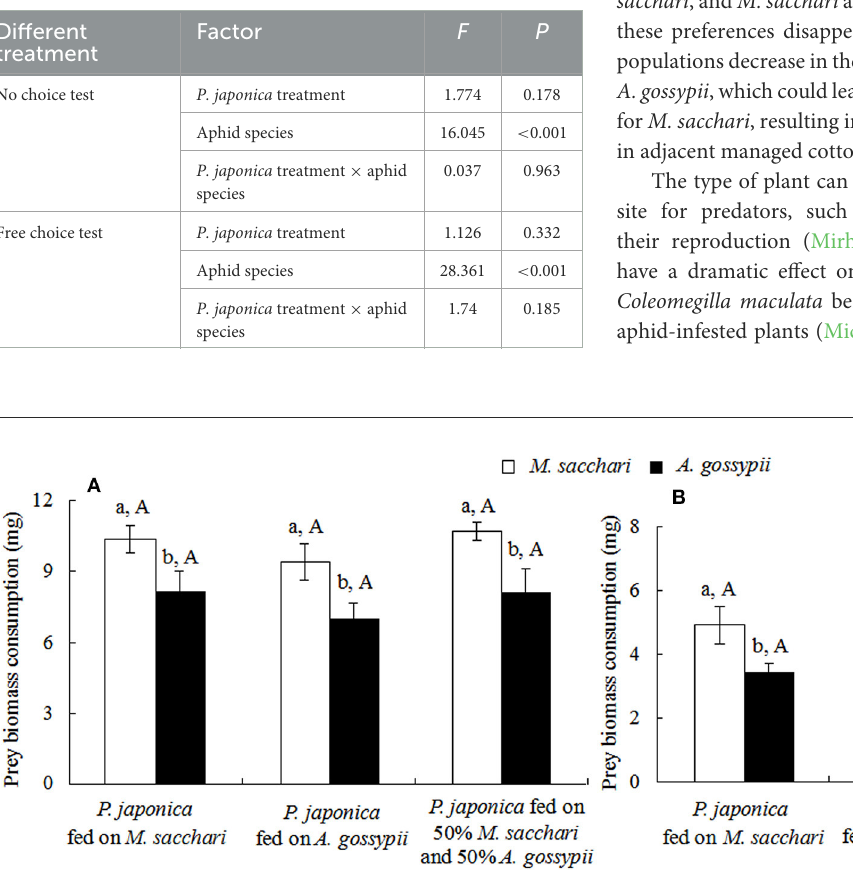
FIGURE4 Effects of aphid species on the prey biomass consumed by adult Propylaea japonica fed different aphid-based diets ( M. sacchari , A. gossypii , and 50% M. sacchari + 50% A. gossypii ) in the no-choice test (A) and free-choice test (B) . Different lowercase letters indicate significant differences between aphid species within a P. japonica treatment, and different uppercase letters indicate significant differences between P. japonica treatments involving different aphid species (Tukey’s test: P <